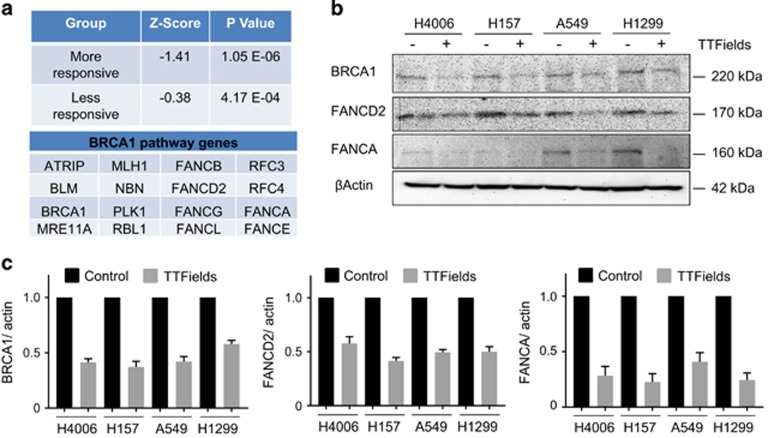
The BRCA1 pathway is downregulated in NSCLC cells exposed to TTFields. (a) z-scores and P-values of BRCA1 pathway gene expression along with the relevant pathway gene names. (b) Immunoblot of representative BRCA1 pathway genes demonstrating the downregulation of BRCA1, FANCD2 and FANCA protein levels resulting from TTFields treatment at 72 h. (c) Quantification of BRCA1, FANCD2 and FANCA protein levels from immunoblots (N=3)